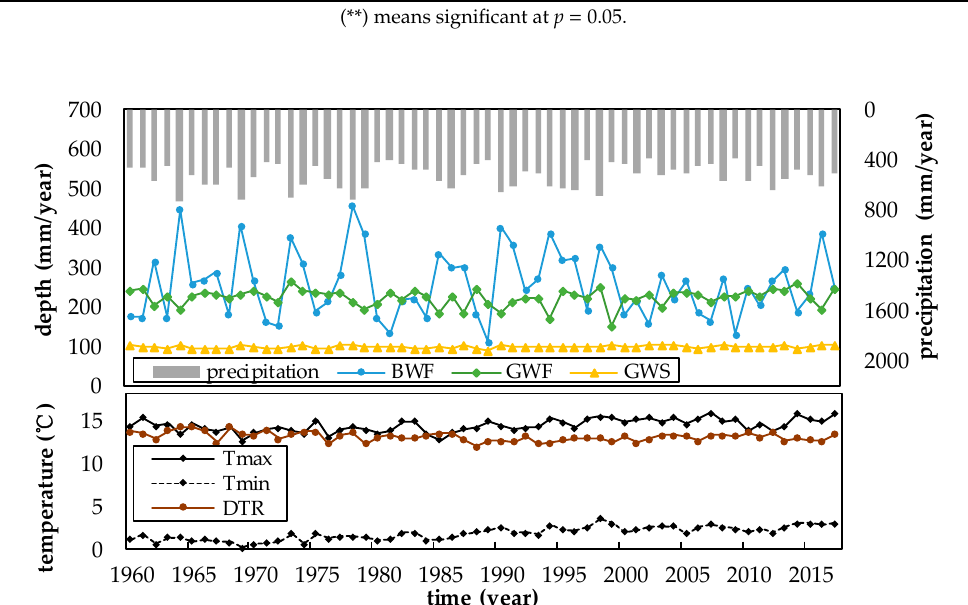
Figure 4. Time varying processes of precipitation and hydrological components in annual scale from 1960 to 2017 in Luanhe River Basin.